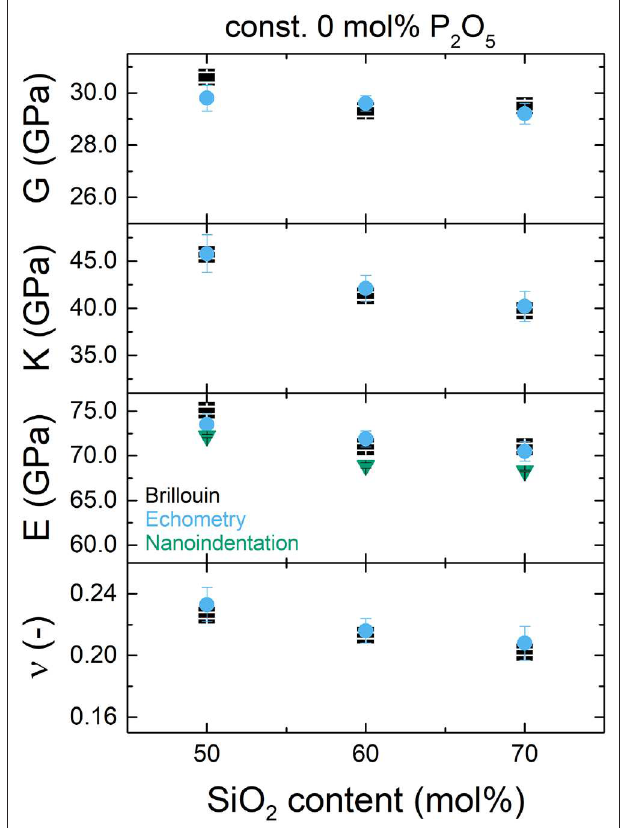
FIGURE 5 | Elastic properties obtained by Brillouin spectroscopy (black squares), ultrasonic echometry (blue circles) and nanoindentation (green triangles, only E) for glasses with 60 mol% SiO 2 and varying phosphate content: (from top to bottom) shear modulus (G), bulk modulus (K), Young’s modulus (E) and Poisson’s ratio ( ν ).